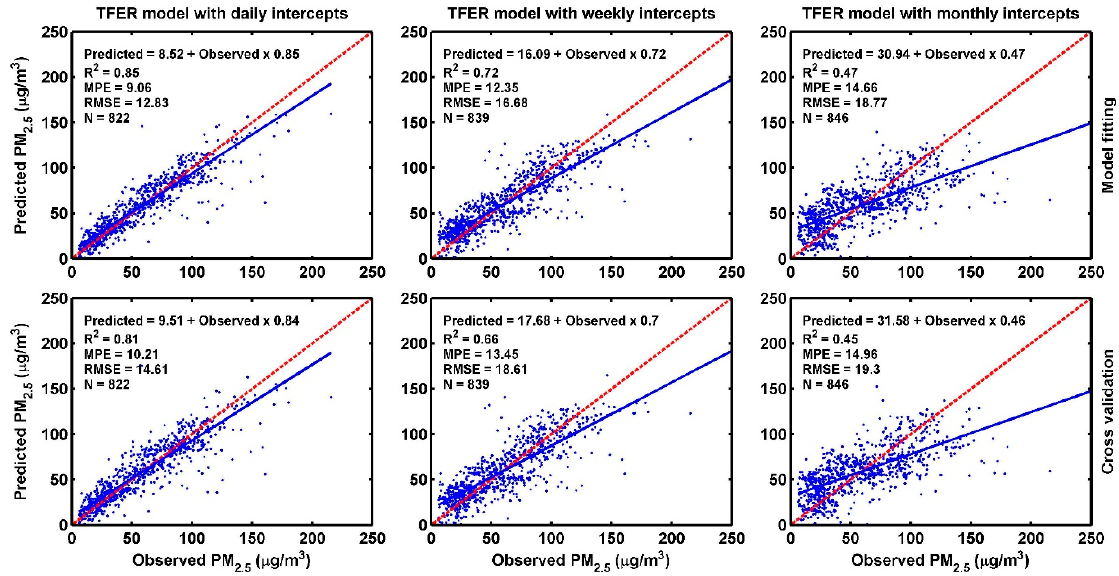
Figure 5. Model fitting and sample-based ten-fold CV results for the first-stage nested TFER model.